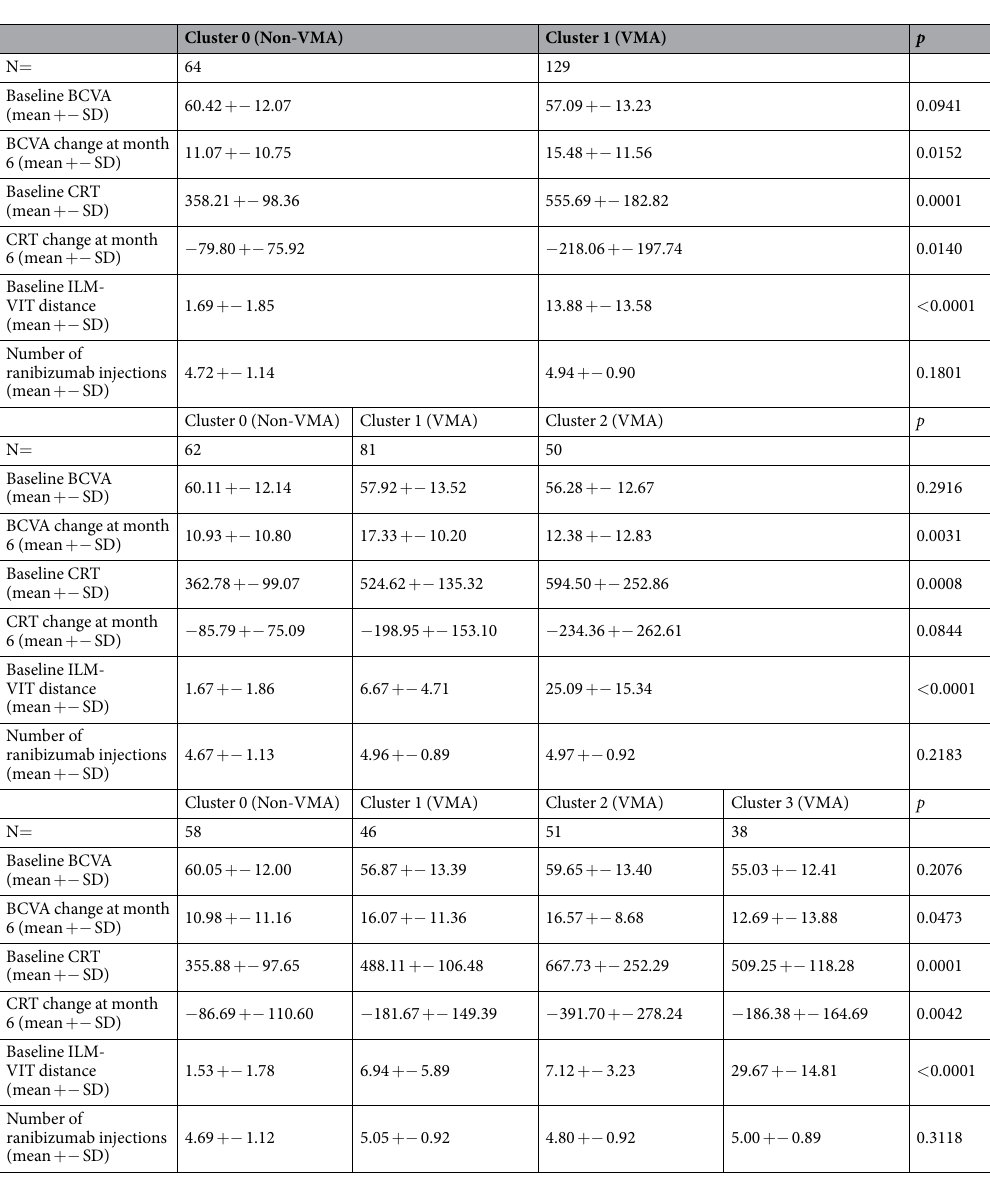
Table 1. Characteristics of vitreomacular interface clusters in branch retinal vein occlusion (BRVO). BCVA = best-corrected visual acuity; SD = standard deviation; CRT = central retinal thickness; ILM = internal limiting membrane; VIT = posterior vitreous